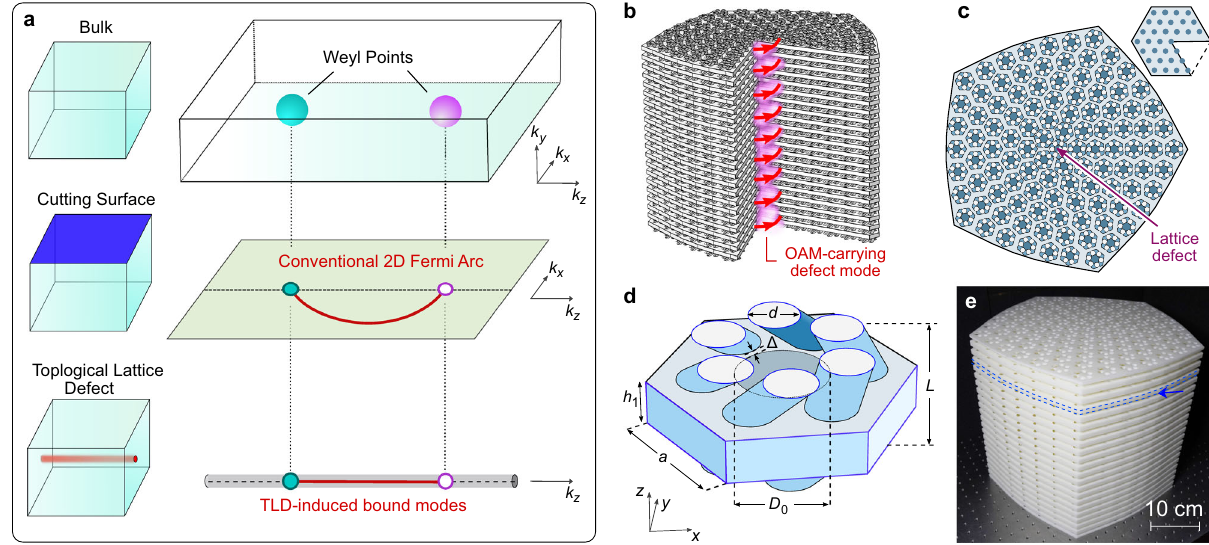
Fig. 1 Weyl acoustic structure with a topological lattice defect (TLD). a Conceptual illustration of the formation of a mode bound to the TLD. Top row: a bulk crystal (left) hosts two Weyl points with opposite topological charges in 3D momentum space (right). Middle row: truncating the crystal (left) creates a Fermi arc extending between the projections of the Weyl points in the 2D surface momentum space (right). Bottom row: adding a TLD (left) results in bound modes that extend between the projections of the Weyl points into the 1D momentum space (right). b Schematic of an acoustic lattice made of chiral layers with a central TLD, stacked along z . A section is omitted to show the internal structure. TLD-bound mode carrying nonzero orbital angular momentum (OAM) propagates along the TLD (pink region). c Top-down schematic of one layer. The TLD is generated by deleting a π /3 wedge from a triangular lattice (inset). d Close-up view of one unit cell. The periodicity in z is L = 1.8 cm. Each unit cell consists of an air- fi lled sheet of thickness h = 0.8 cm, with a central solid rod of diameter D = 1.6 cm ringed by six skewed air- fi lled tubes of diameter d = 0.9 cm in a hexagonal arrangement. The 1 0 tubes advance by π /6 around the hexagon between layers. The spacing between the central rod and the tubes is Δ = 0.1 cm, and the side length of the ffiffiffi p hexagonal cell is a ¼ 4 = 3 cm. All other regions are solid resin. e Photograph of the experimental sample with 21 layers. Blue dashes indicate one of the layers, and the arrow indicates one of the gaps for inserting acoustic